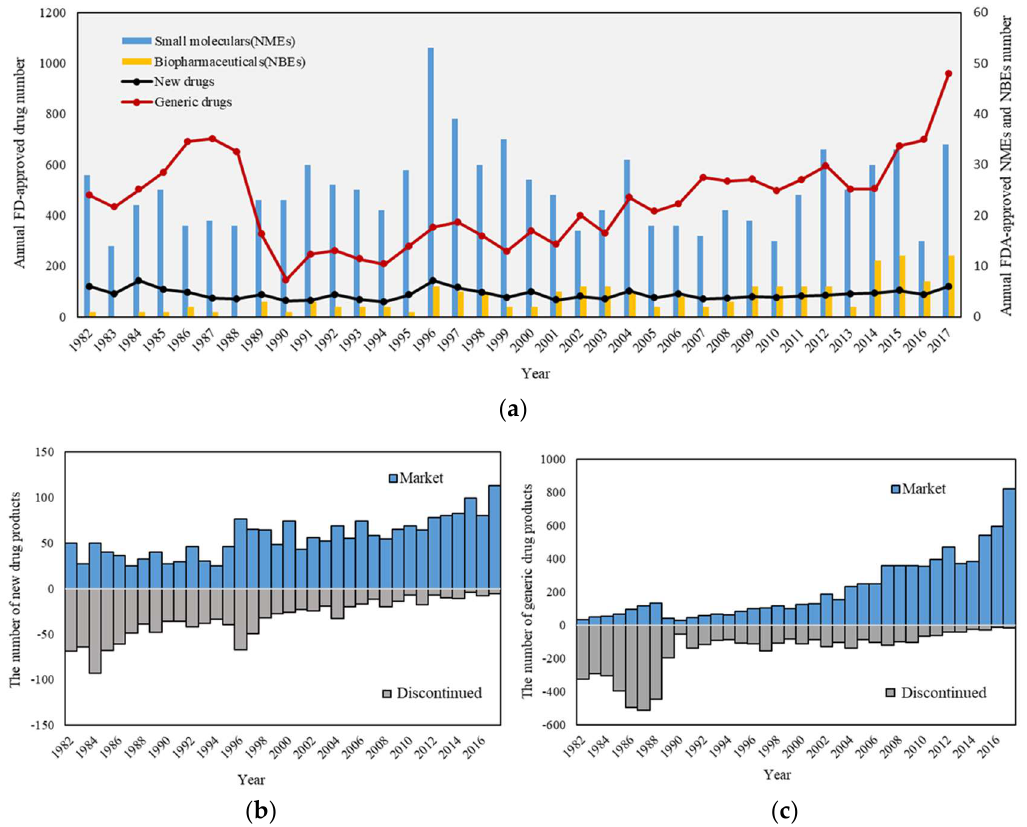
Figure 2. ( a ) The timeline of FDA-approved pharmaceutical products. ( b ) The number of marketed and discontinued new drugs. ( c ) The number of marketed and discontinued generic drugs. The blue columns represent marketed drugs and the grey columns represent discontinued drugs.